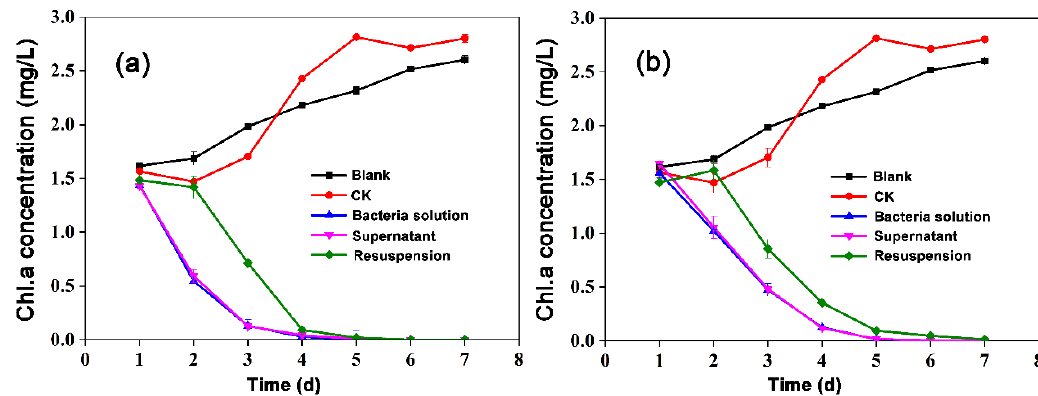
Figure 7. The effects of bacterial culture liquid treated with different methods on chlorophyll-a of Microcystis aeruginosa . ( a ) strain 39 # and ( b ) strain 91 # . Microcystis aeruginosa. ( a ) strain 39 # and ( b ) strain 91 # .